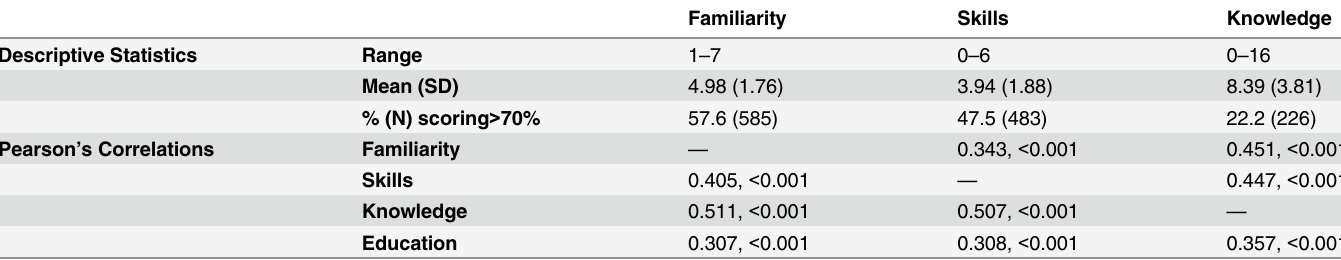
Table 2. Descriptive statistics and Pearson ’ s Correlations of Genetic Literacy